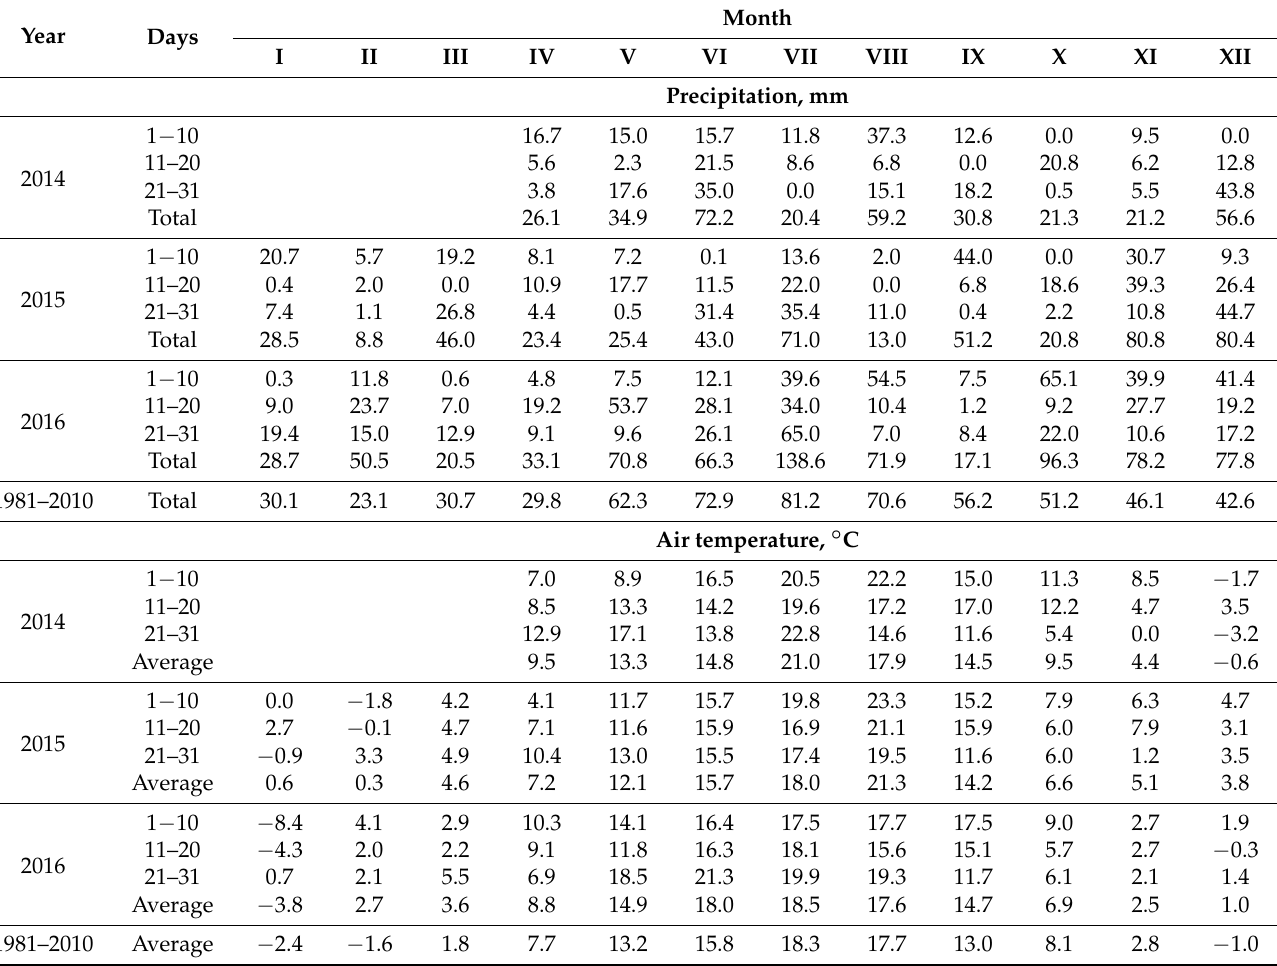
Table 8. Precipitation and air temperature during the study period according to the Meteorological Station in Bałcyny